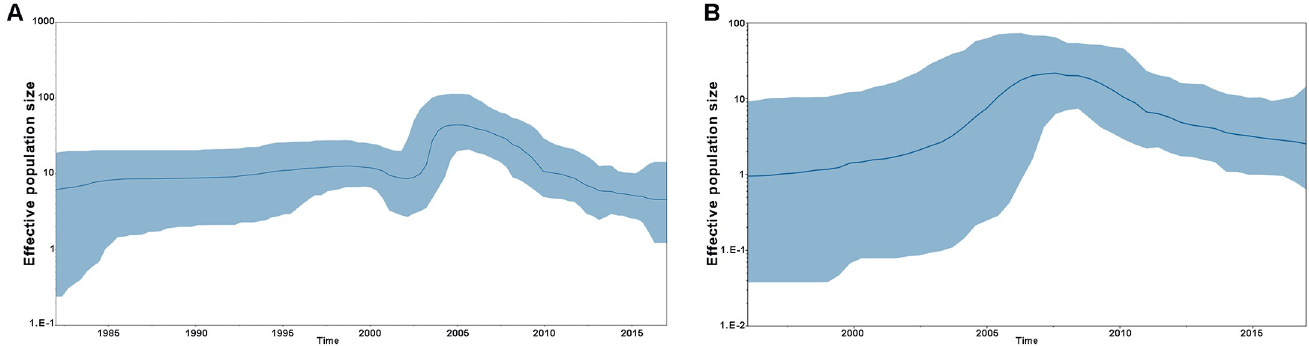
Fig 2. Bayesian skyline plot of RV-A101 (A) and RV-C45 (B). Bayesian skyline plots of the RV-A101 (A) and RV-C45 (B) genes show the changes in effective population size (genetic diversity) through time. The thick solid line indicates the median value, and the blue area is the 95% Highest Posterior Density (HPD) of the genetic diversity